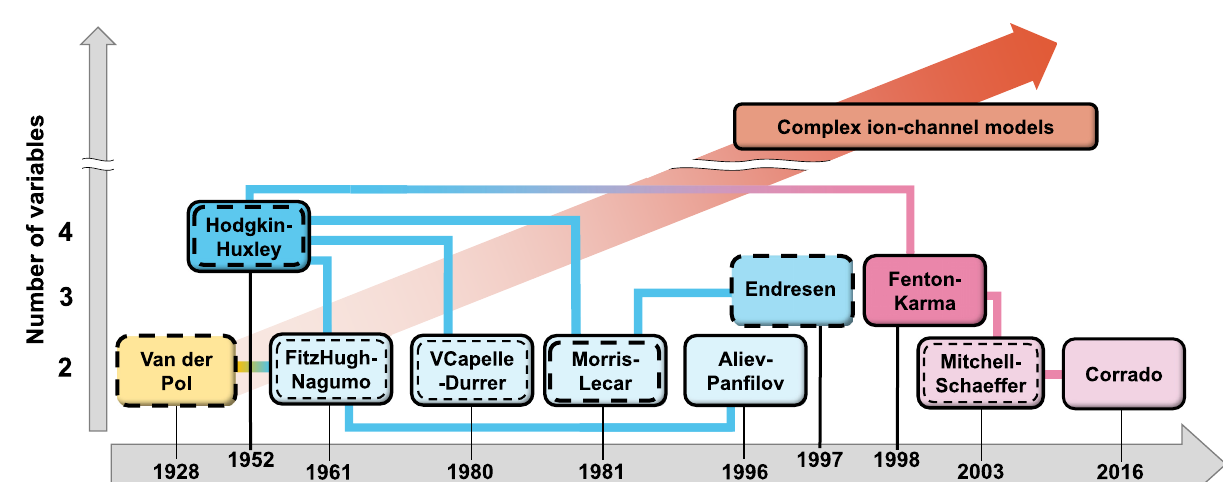
Fig 1. Timeline of simplified physiological cell models development. Solid shapes correspond to excitable cell models, dashed shapes—to pacemaking cell models, respectively.